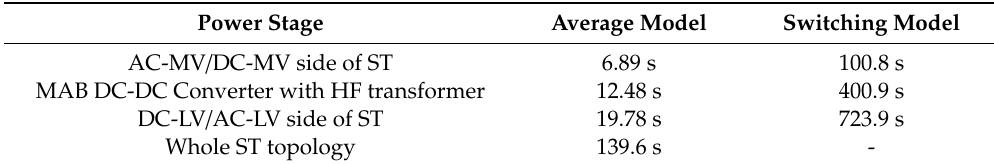
Table 3. The simulation times of the average model and fully switched model for the selected ST stages and the whole ST.